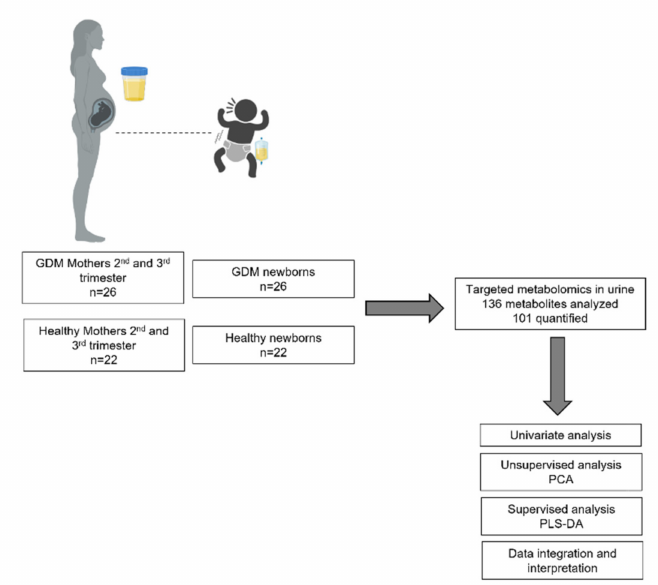
Figure 4. Study design: Longitudinal study of 48 mother–newborn